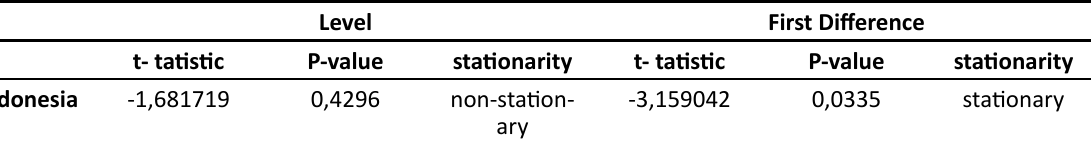
Table 1: Results of Augmented Dickey-Fuller Test for ASEAN-5